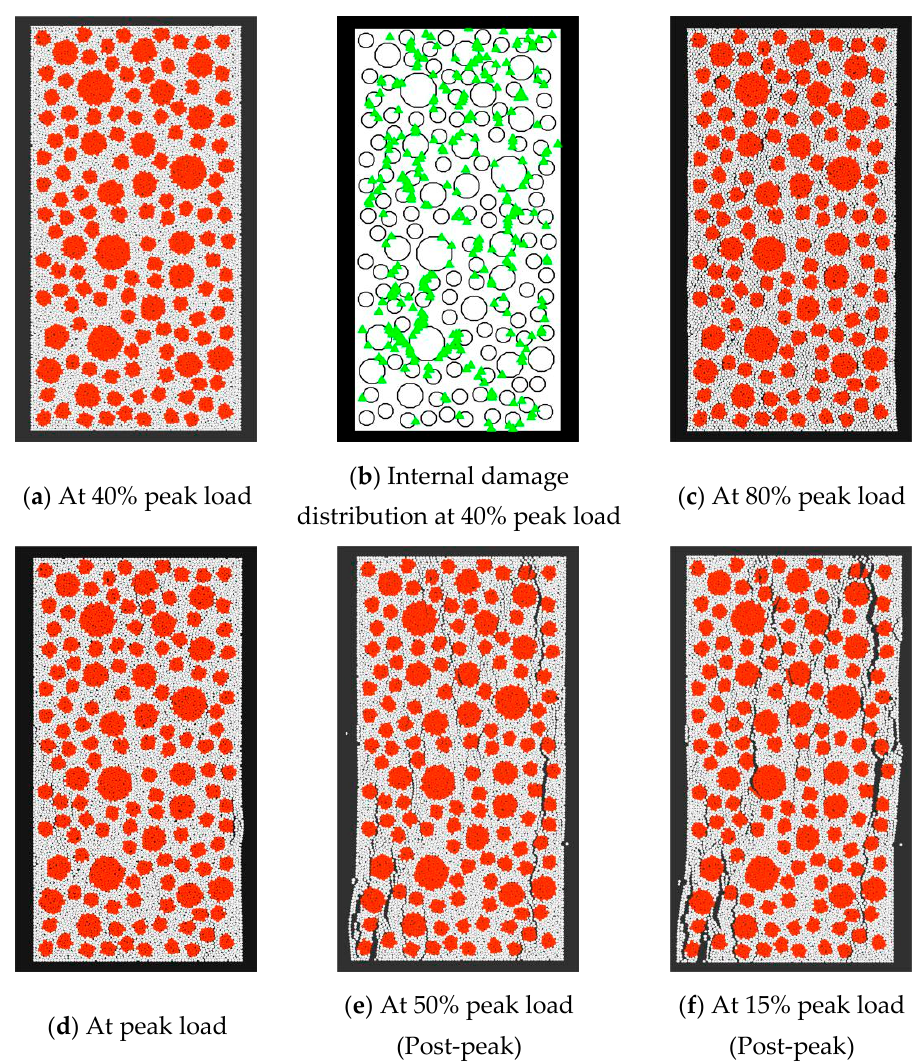
Figure 5. Numerical crack development in ordinary concrete under compression.